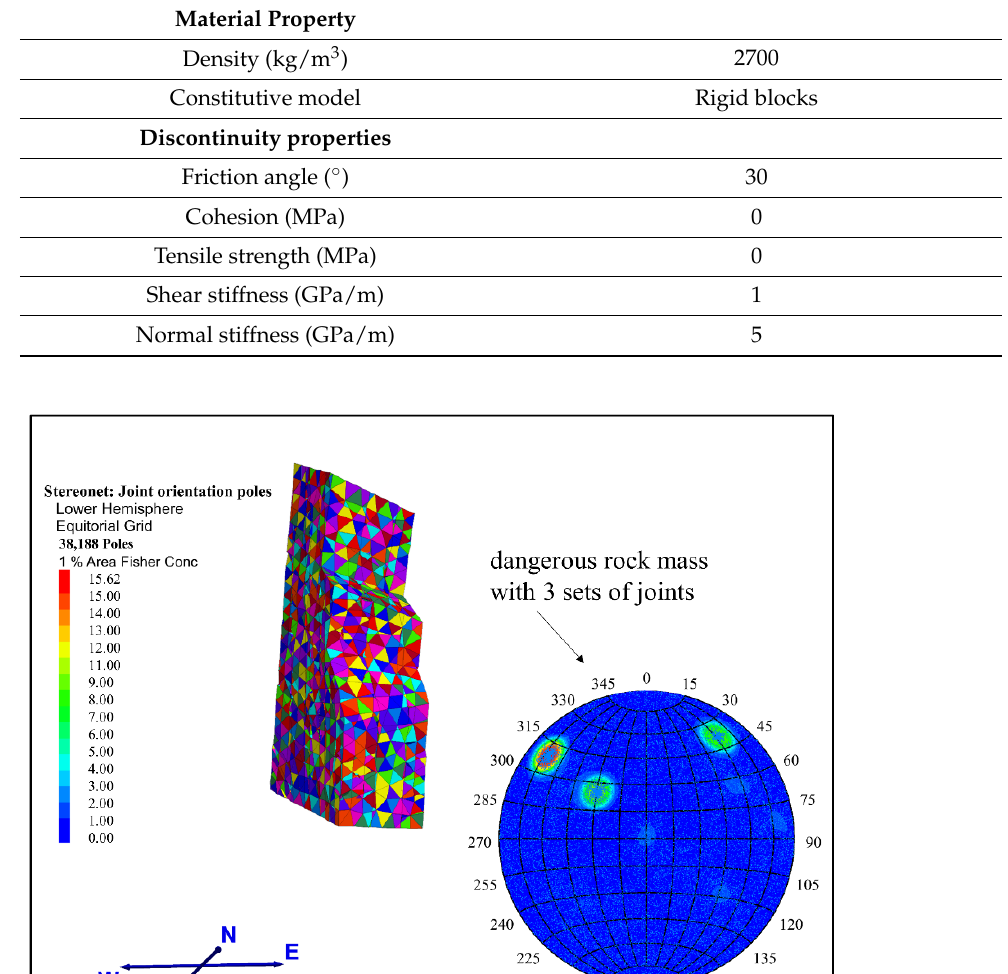
Table 5. Physical and mechanical properties used in the 3DEC model.